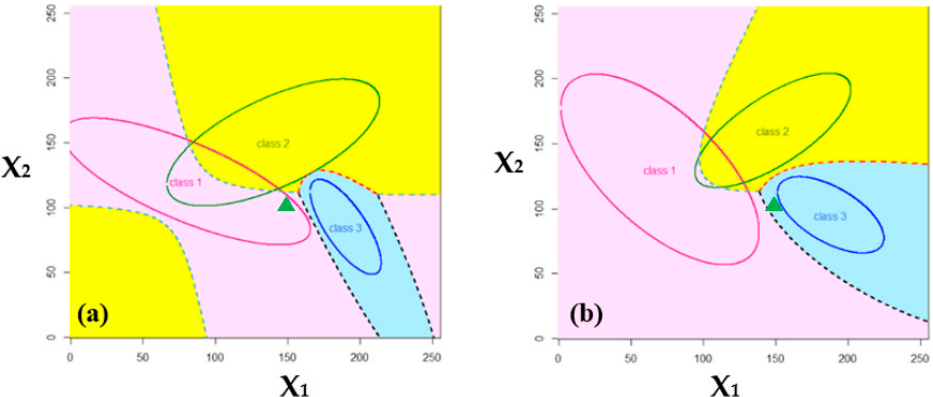
Figure 4. Exemplary illustration of the three-class partitioning of a two-dimensional feature space derived from the Bayes classification method. The classification features (X 1 and X 2 ) of individual classes in Panels ( a ) and ( b ) are characterized by multivariate Gaussian distributions with the parameters listed in Table 2. The ellipses represent the 95% probability contours of individual classes, and the dashed lines are the boundaries of different classes. Regions belonging to different classes are shown in different colors. A sample point (marked by (cid:78) ) is classified into different classes under different distribution parameters.